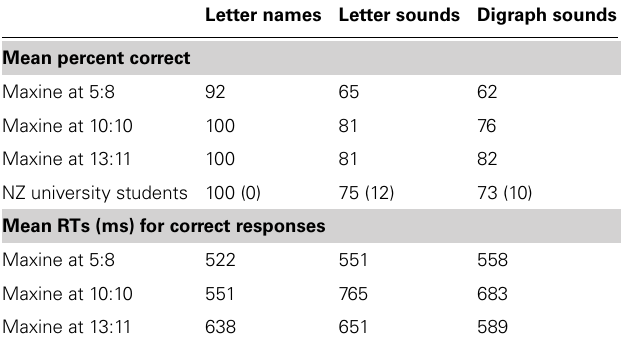
Table 2 | Experiment 1: Mean percentage accuracy and response times (RTs) for lowercase letter names, letter sounds, and digraph sounds for Maxine at 5:8, 10:10, and 13:11, and for the NZ university students without phonics instruction (standard deviation in